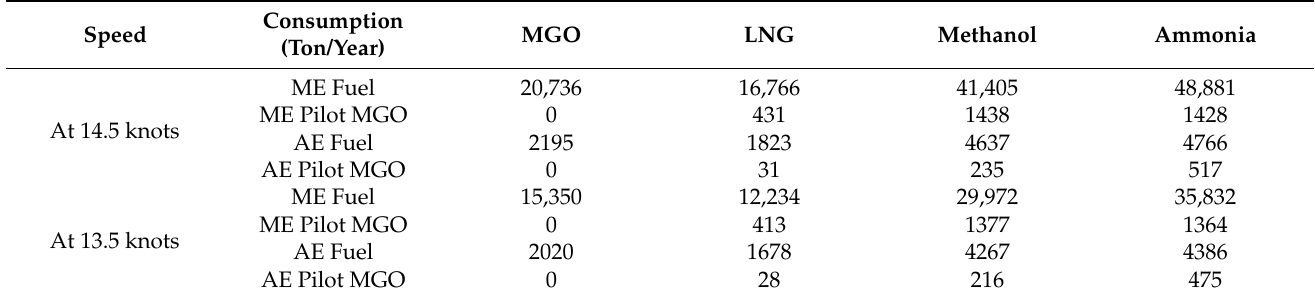
Table 6. Fuel consumption of ME and AEs.